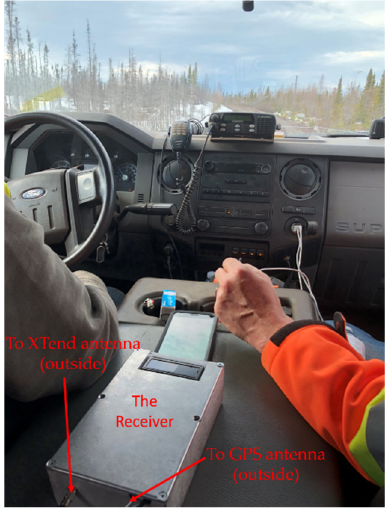
Figure 23. Receiver in the Hi-Rail pickup.